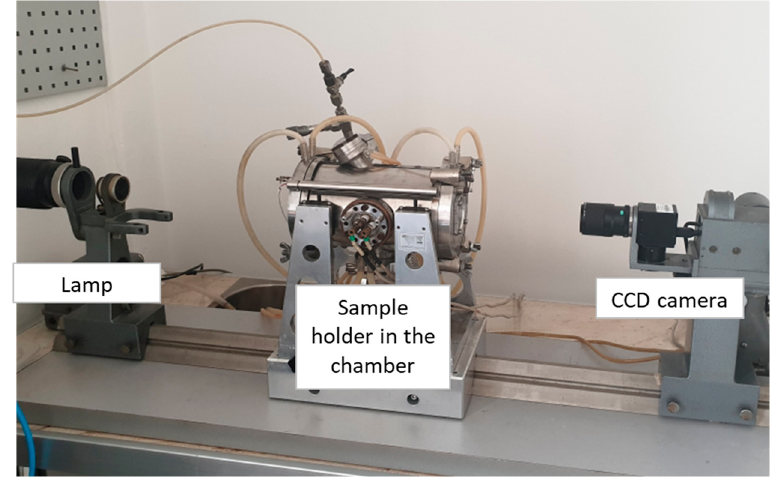
Figure 1. Equipment for the contact angle